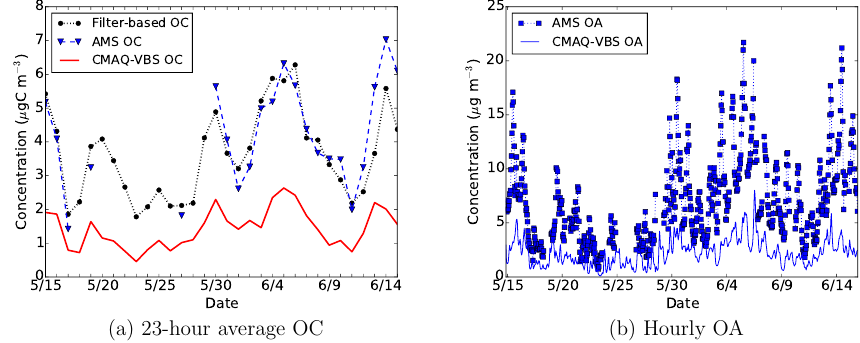
Figure 2. (a) Modeled and measured (EPA filter-based and AMS) 23h average OC and (b) hourly modeled and AMS-measured OA at Pasadena. AMS measurements in (a) were converted to OC using OM to OC ratios reported in Hayes et al. (2013) and include only days with > 16hourly measurements (i.e., 18, 20–26, 28, and 29 May are excluded due to missing measurements).